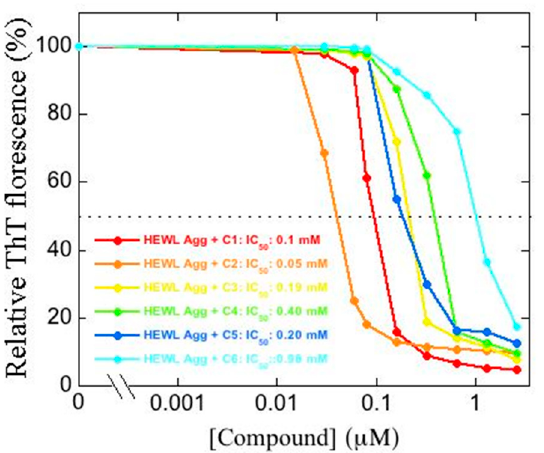
Figure 2. Concentration-dependent prevention of HEWL amyloid fibril formation by compounds 1– 6 incubated as described in Figure 1 at different compound concentrations, ranging from 0.03 to 2.6 µM. The traces refer to compound 1 (red), compound 2 (orange), compound 3 (yellow), compound 4 (green), compound 5 (blue), and compound 6 (indigo). The dotted line indicates a level of 50%.